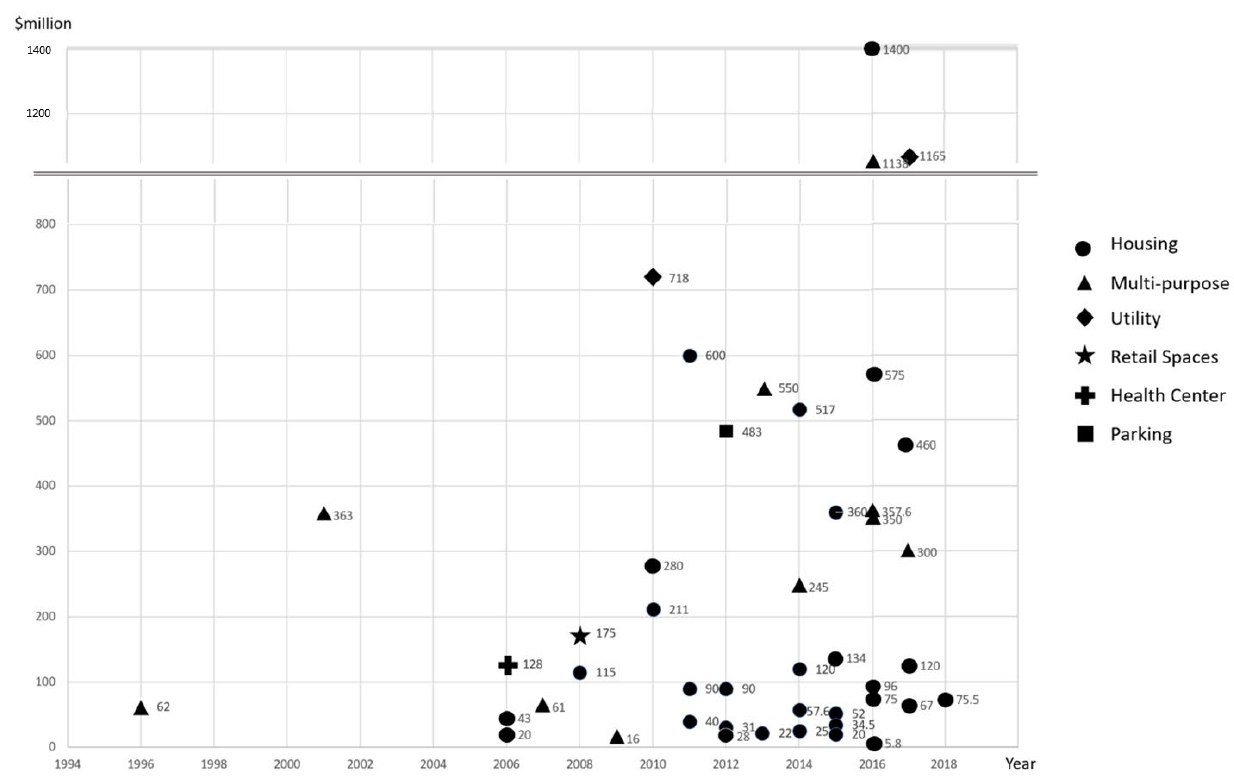
Figure 2. PPP Projects in higher education institutions by year and size.